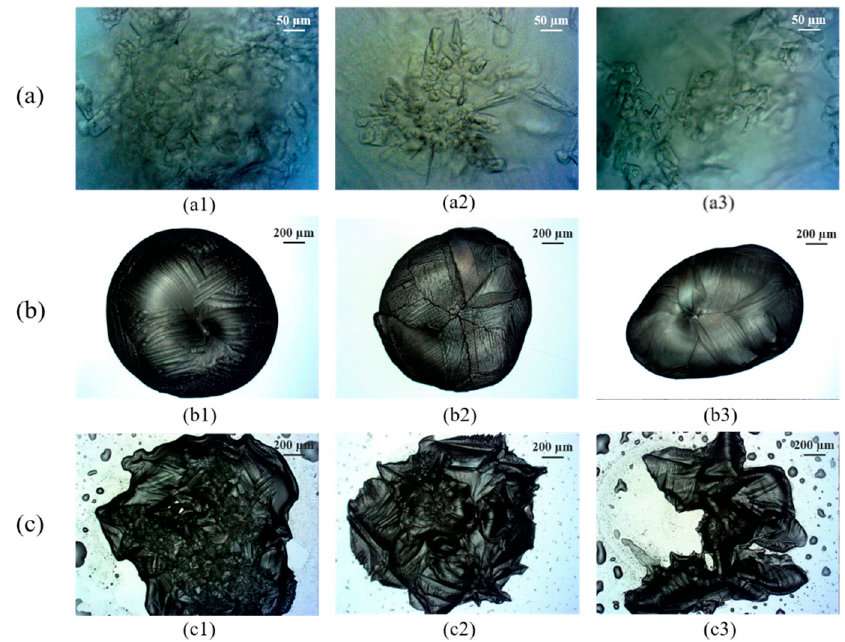
Figure 4. Crystal morphologies of ( a ) R141b; ( b ) TME, and ( c ) TBAB/TBAC hydrates at 5 °C and 0.1 MPa, for a sequence of repeated experiments (Case 1–3).